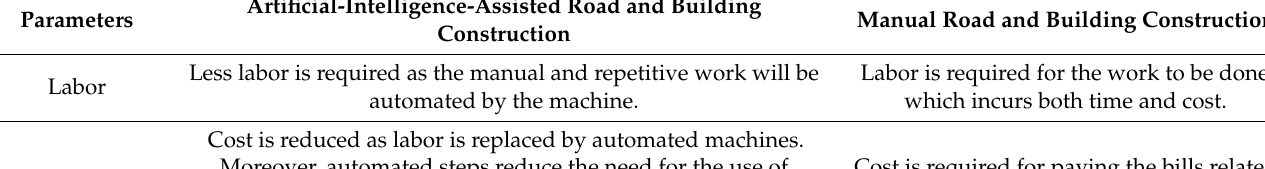
Table 1. Comparison of artificial intelligence (AI)-assisted vs. manual construction of roads and buildings.